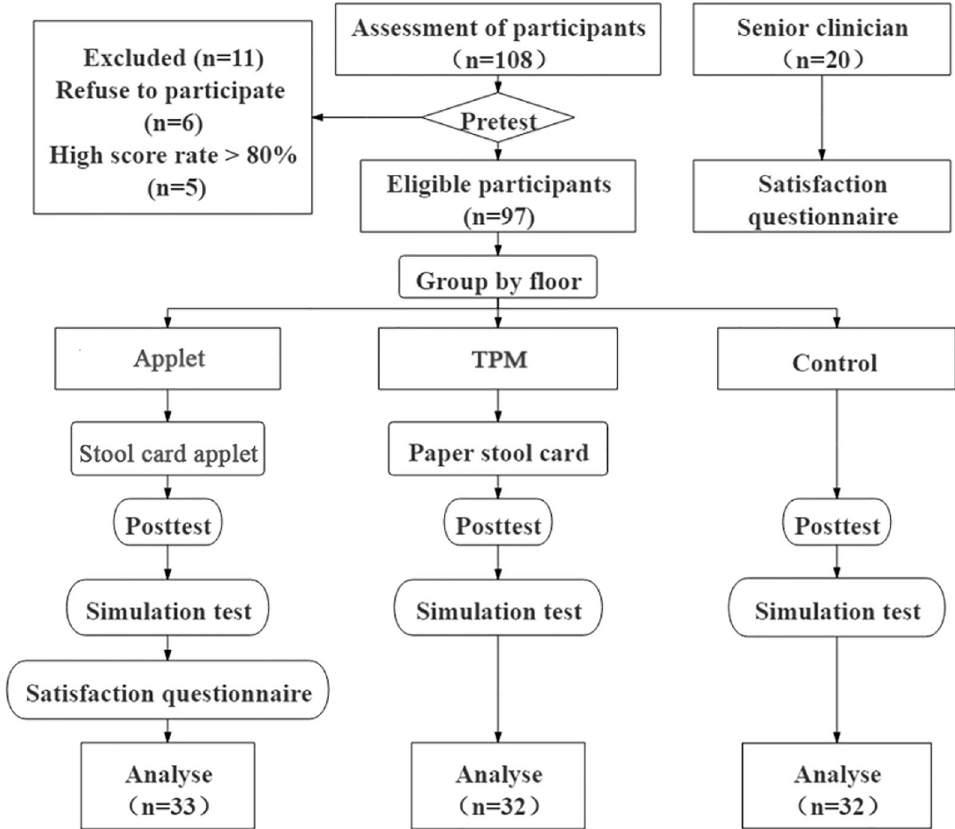
Figure 2. Flowchart showing details of participant selection, grouping, and testing. Applet: applet group; TPM: traditional paper media group.